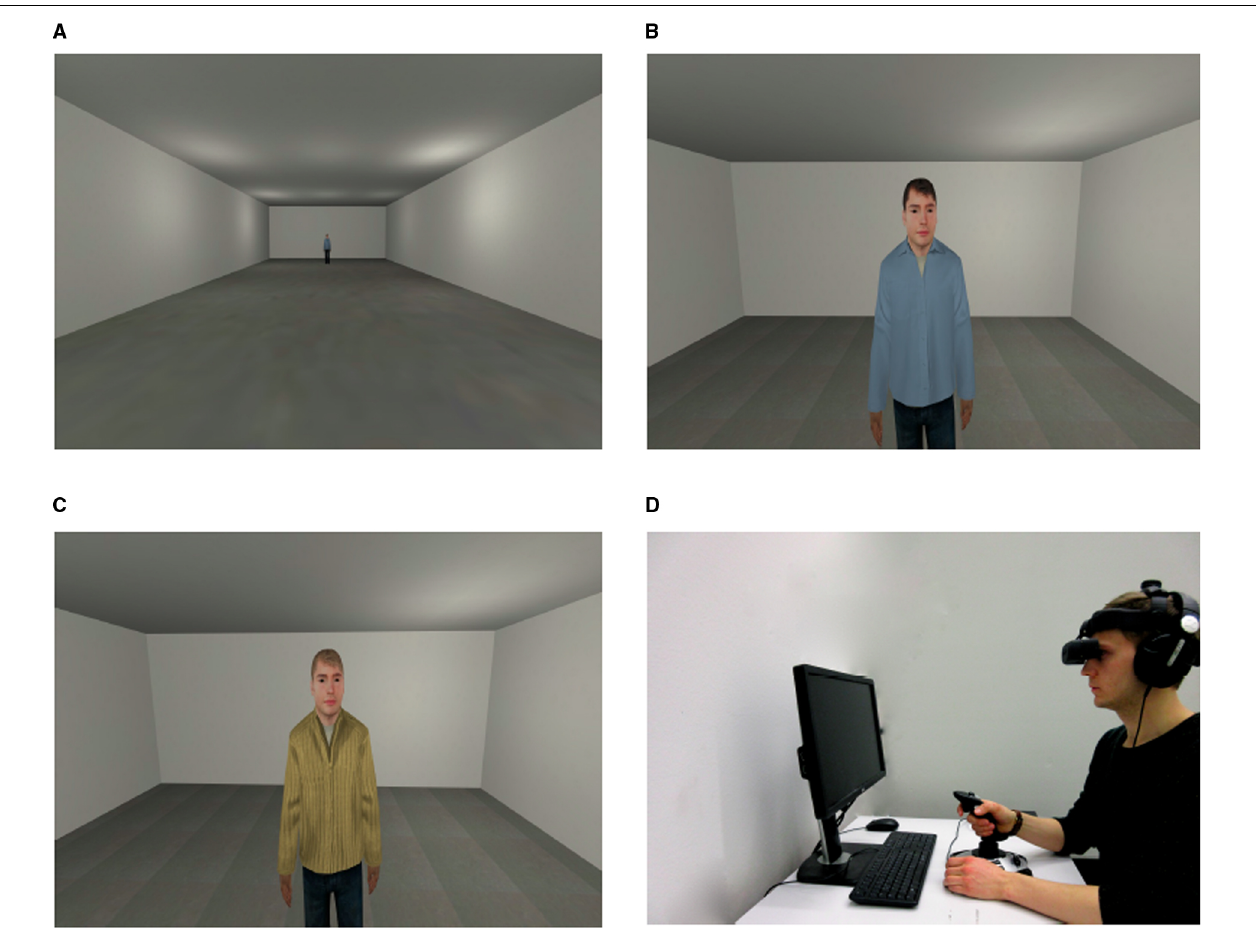
FIGURE 1 | Virtual environment. (A) Room where acquisition and extinction phase in VR took place. (B,C) Two of the social stimuli (agents) used for the conditioning. (D) Setting (VR was presented via a head-mounted-display) during the experiment (laboratory room was darkened).